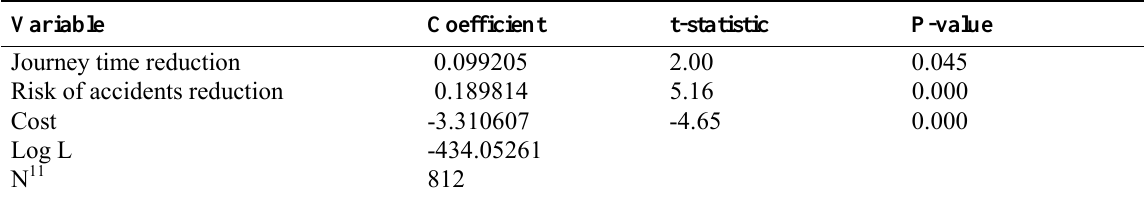
Table 3. Choice experiment: Coefficient estimates Variable Coefficient t-statistic